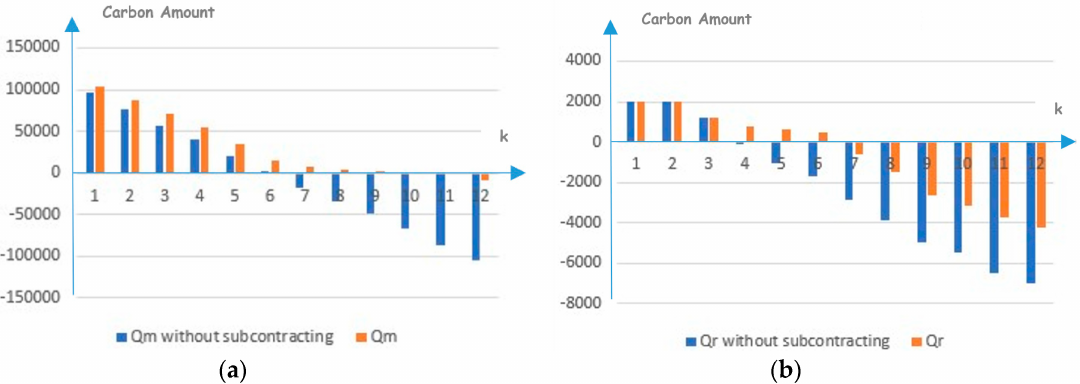
Figure 7. Amount of emitted carbon with and without subcontracting unit for C ps = 35; C c = 3550. ( a ) Manufacturing unit; ( b ) Remanufacturing unit.